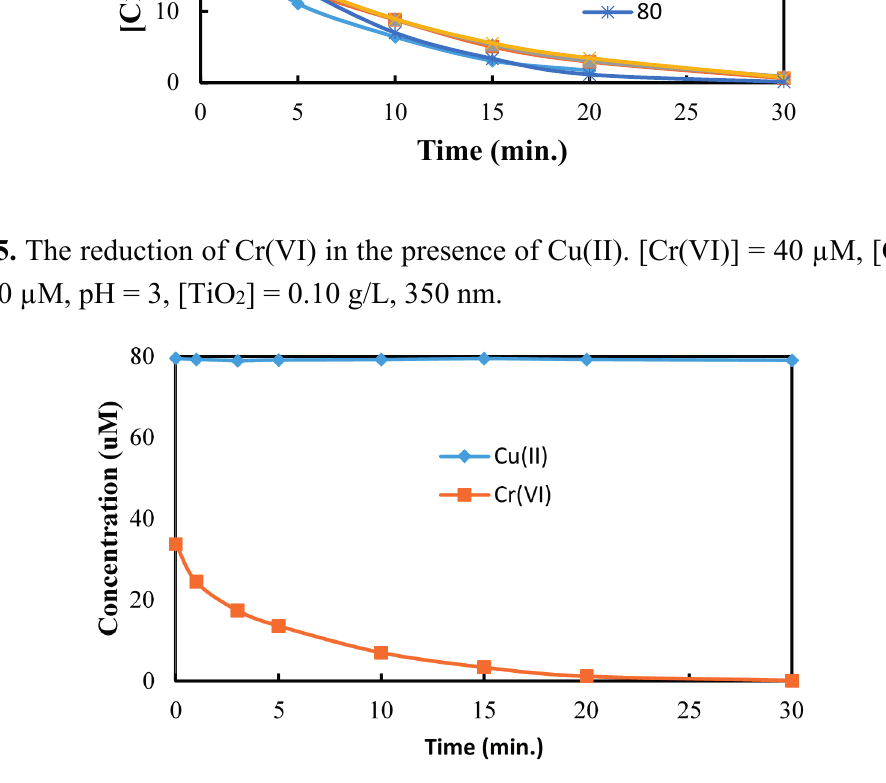
Figure 6. The reduction of Cu (II) in presence of Cr(VI). [Cr(VI)] 0 = 40 µM, [Cu(II)] 0 = 80 µM, pH = 3, [TiO 2 ] = 0.10 g/L, 350